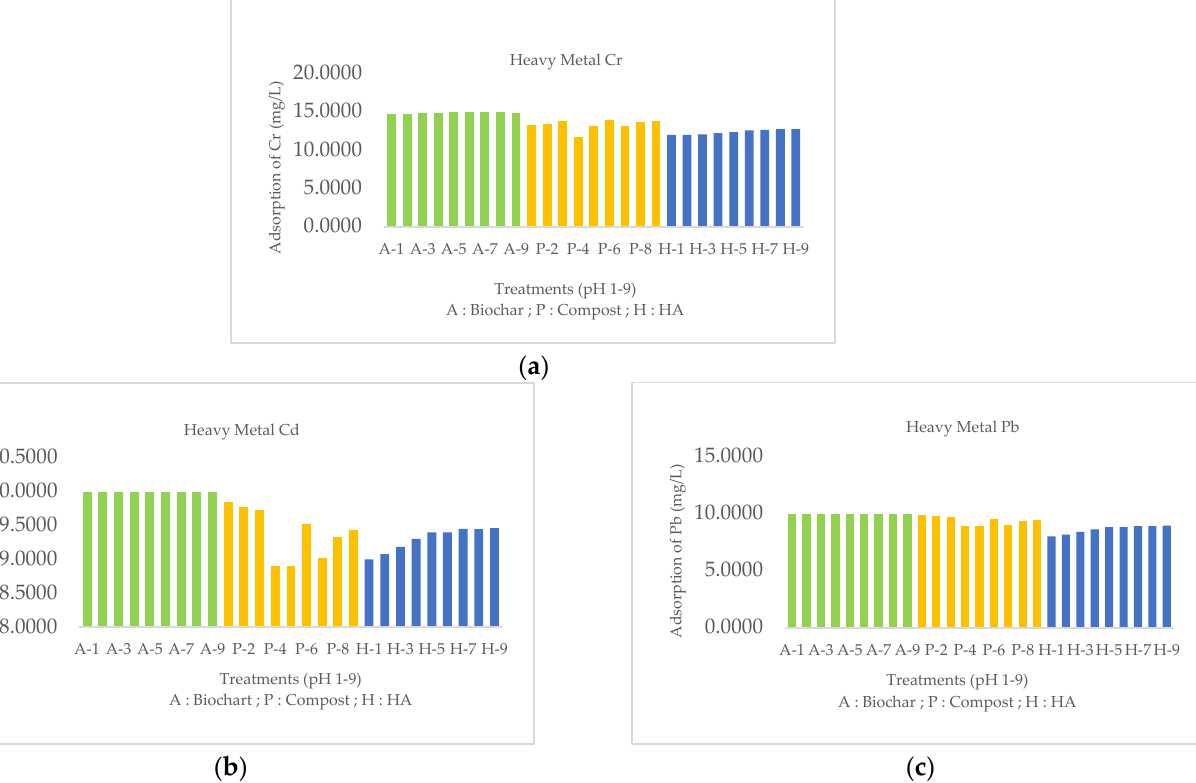
Figure 3. The adsorption of heavy metals Cr ( a ), Cd ( b ) and Pb ( c ) at various pH levels.